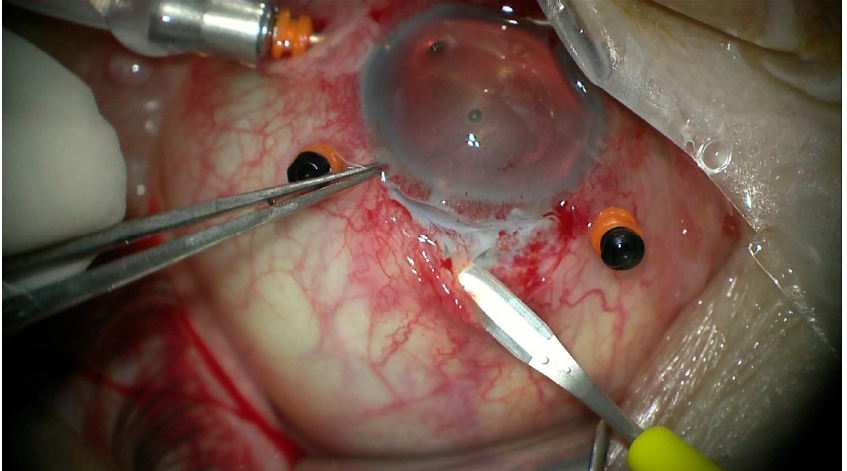
Figure 2. Performing a scleral triangle flap.